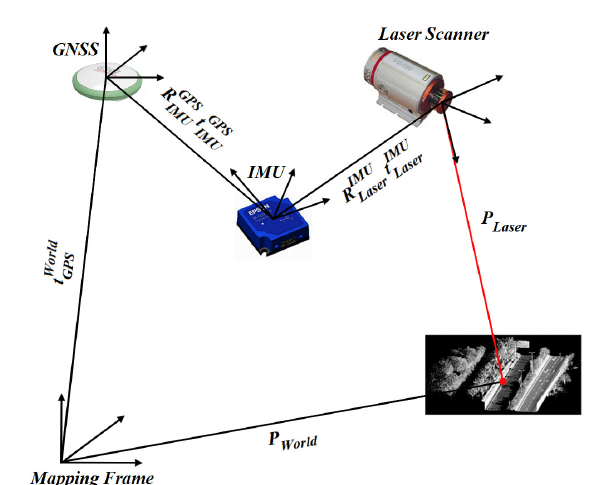
Figure 3. General working principal of mobile mapping sys-